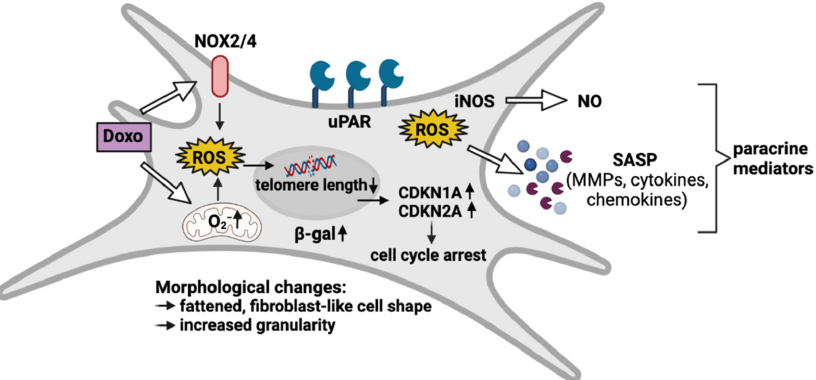
Figure 7. Overview of Doxo-mediated SIPS in hAC. Doxo treatment leads to oxidative stress by enhanced expression of ROS-generating NADPH oxidases (NOX2/4) and disturbance of mitochon- drial function. Subsequent DNA damage results in upregulation of CDKN1A and CDKN2A, which initiate cell cycle arrest. ROS accumulation further triggers the expression of NO-generating iNOS and SASP factors. These paracrine mediators create a pro-inflammatory and catabolic microenviron- ment, not only fueling the progression of cartilage degeneration but also the spread of senescence. Moreover, Doxo-treated hAC express high levels of membrane-associated uPAR and intracellular β -gal, which are both well-described markers in chondrosenescence. Morphologically, senescent hAC are characterized by a flattened, fibroblast-like cell shape and an increase in granular- ity.